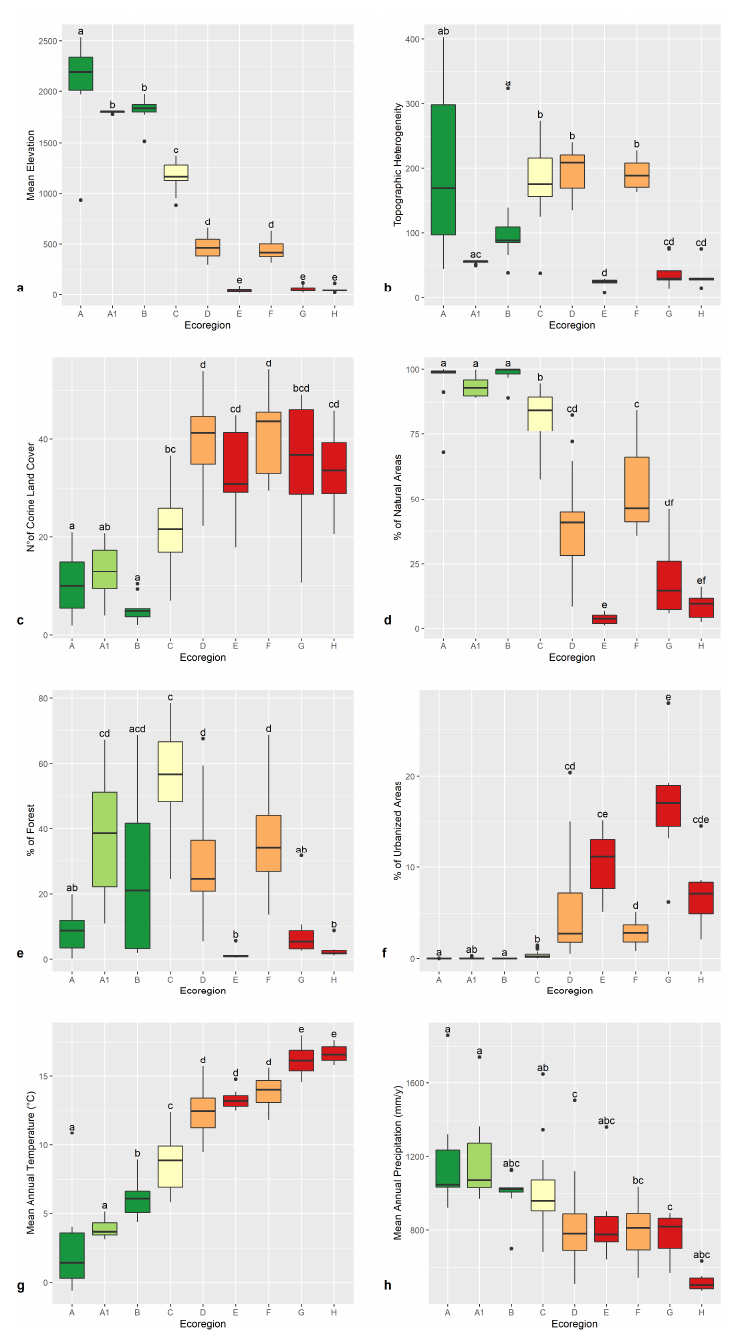
Figure 4. Box-plot graphs depicting average altitude (m) ( a ), topographic diversity ( b ), landscape heterogeneity ( c ), percentage of natural and semi-natural habitats ( d ), percentage of woodland surface ( e ), percentage of anthropized surface ( f ), average mean temperature ( g ), average precipitation ( h ) for the OGUs of the 9 ecoregions: Alpine (A), Subalpine (A1), Oromediterranean (B), Montane (C), Dry Submediterranean (D), Padanian (E), Humid Submediterranean (F), Humid Mediterranean (G), Dry Mediterranean (H). Significant di ff erences are labeled by di ff erent letters (Wilcoxon test). Box colors show ecoregions with the same altitudinal range. Color codes are green (high-altitude ecoregions), yellow (Montane ecoregion), orange (Submediterranean ecoregions), and red (Mediterranean